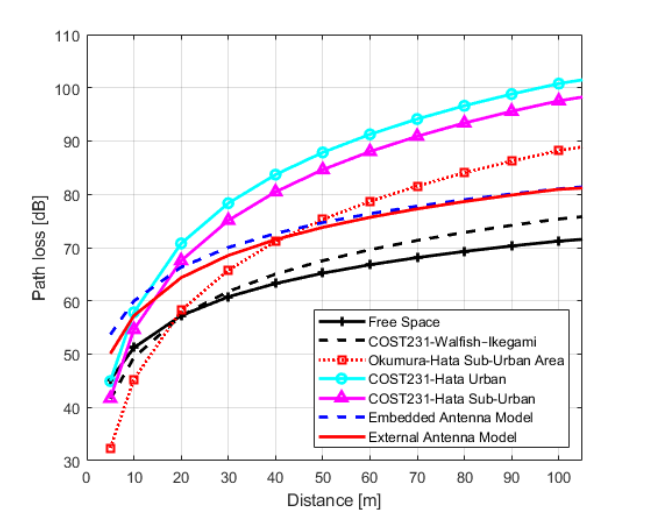
Figure 10. IQRF path loss model for Non-Line-of-Sight scenario (two-turns).